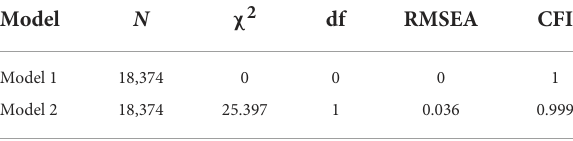
TABLE 2 Fit statistics of the education and depression models. TABLE 3 Standardized regression weight of the effects of education on depression of Model 1 and Model 2 *